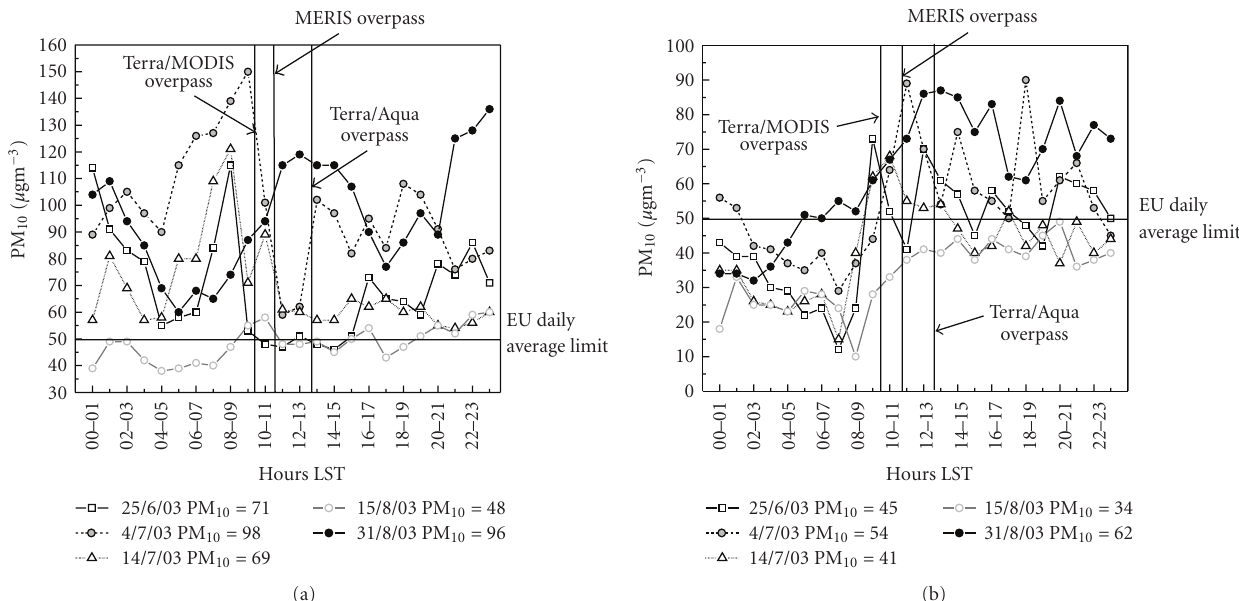
Figure 7: Diurnal variation of the PM 10 concentrations at (a) urban “Aristotelous” station, and (b) suburban “Zografou” station for the five days considered. The EU threshold daily mean value of 50 μ gm − 3 is also